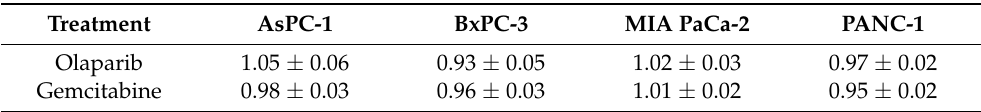
Table 1. Surviving fraction calculated after treatment with olaparib (1 µ M) or gemcitabine (10 nM) for AsPC-1, BxPC-3, MIA PaCa-2 and PANC-1 cell lines.